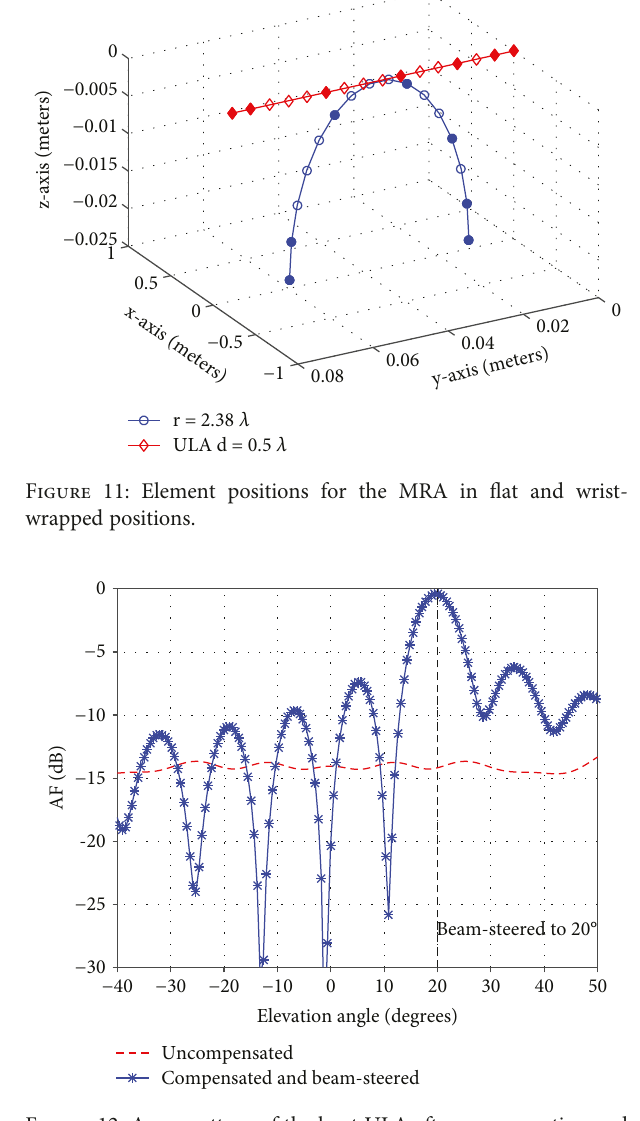
Figure 12: Array pattern of the bent ULA after compensation and beam-steering.